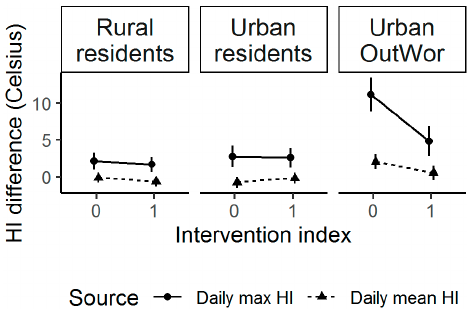
Figure 5. The mean HI difference (°C) between individually experienced HI and HI measured at the nearest weather station on baseline days (intervention index = 0) and intervention days (intervention index = 1). The 95% confidence intervals are shown. Table 3. Intervention effects on daily mean heat index (°C) experienced by individuals in different population groups.